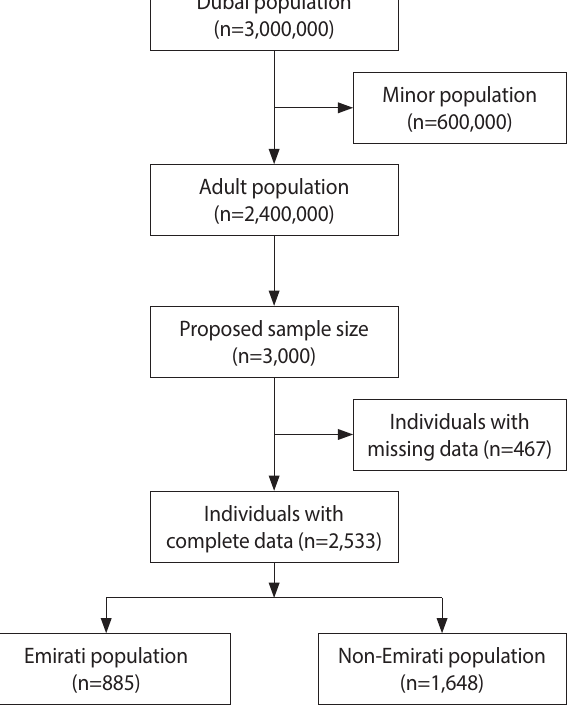
Figure 1. Flowchart of the study